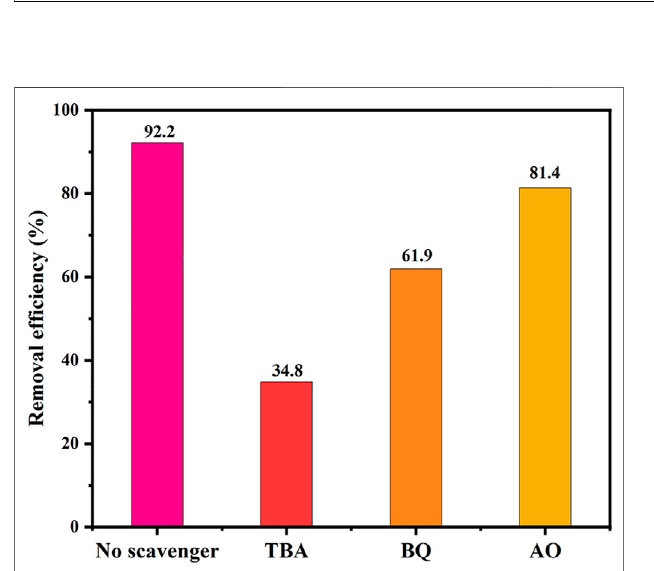
FIGURE 12 | Intermediates and reaction pathways of TCH photodegradation under visible light illumination over ZF-Sep-11.